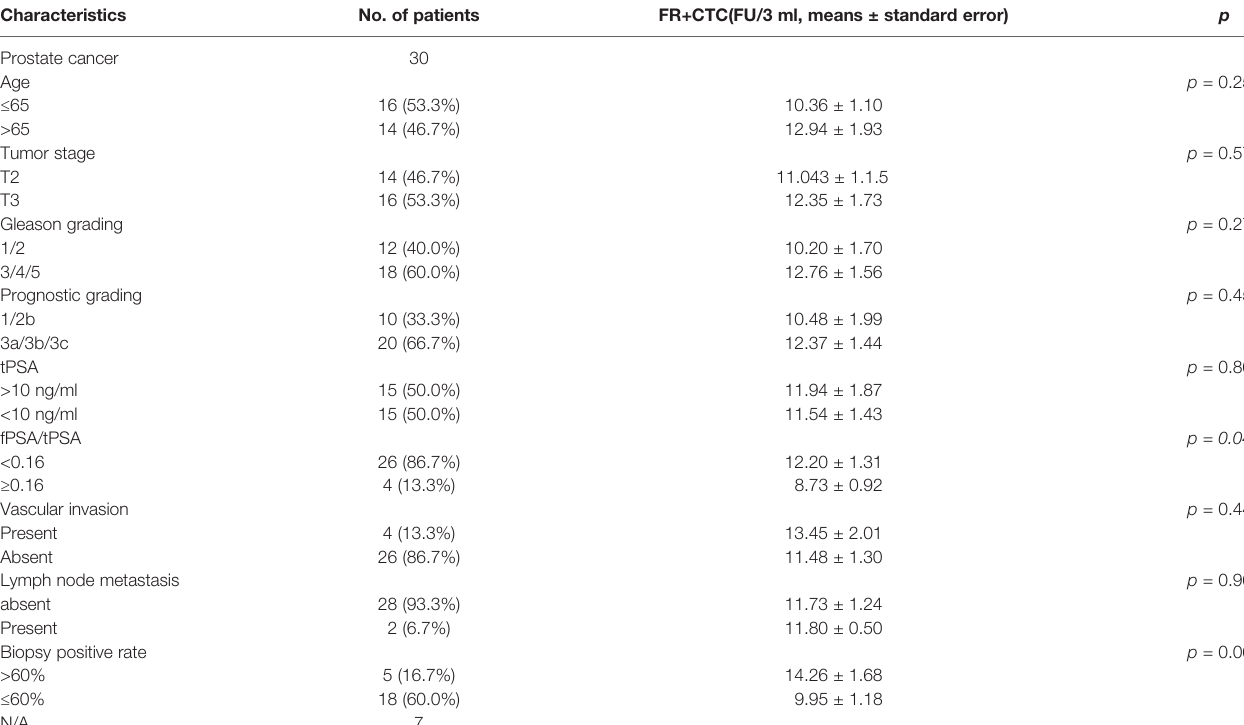
TABLE 2 | Correlation of FR+CTCs levels and clinical characteristics in prostate cancer.